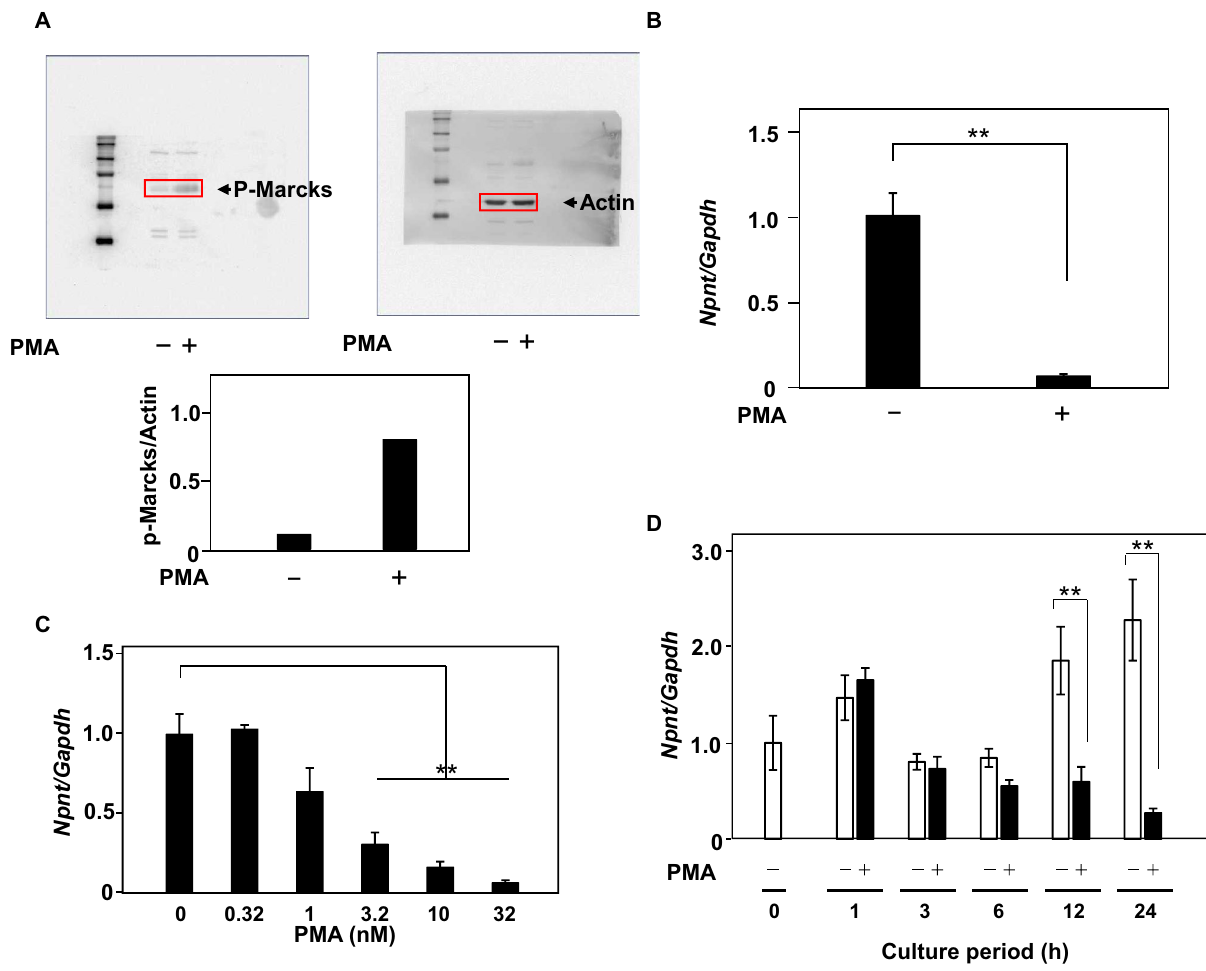
Figure 3. Effects of PMA on Npnt gene expression. ( A ) MC3T3-E1 cells were starved for 16 h in serum-free medium. Cells were treated with or without PMA (100 nM) for five minutes, then proteins were extracted and subjected to western blotting to detect phosphorylation of Marcks (p-Marcks) and actin. ( B ) MC3T3-E1 cells were treated with PMA (10 nM) for 24 h. Total cellular RNA was extracted, and mRNA levels of Npnt and Gapdh were examined using quantitative real-time PCR analysis. ( C ) Dose-dependent effects of PMA on Npnt expression. MC3T3-E1 cells were treated with PMA (0, 0.32, 1, 3.2, 10, or 32 nM) for 24 h and then examined using quantitative real-time PCR analysis. ( D ) Time course analysis of PMA effects on Npnt gene expression. MC3T3-E1 cells were treated with PMA (10 nM) for 0, 1, 3, 6, 12, or 24 h and then examined using quantitative real-time PCR analysis. Results are shown as the mean ± SD of 3 samples. ** P < 0.01, Student’s t-test as compared to the level with 0 nM of